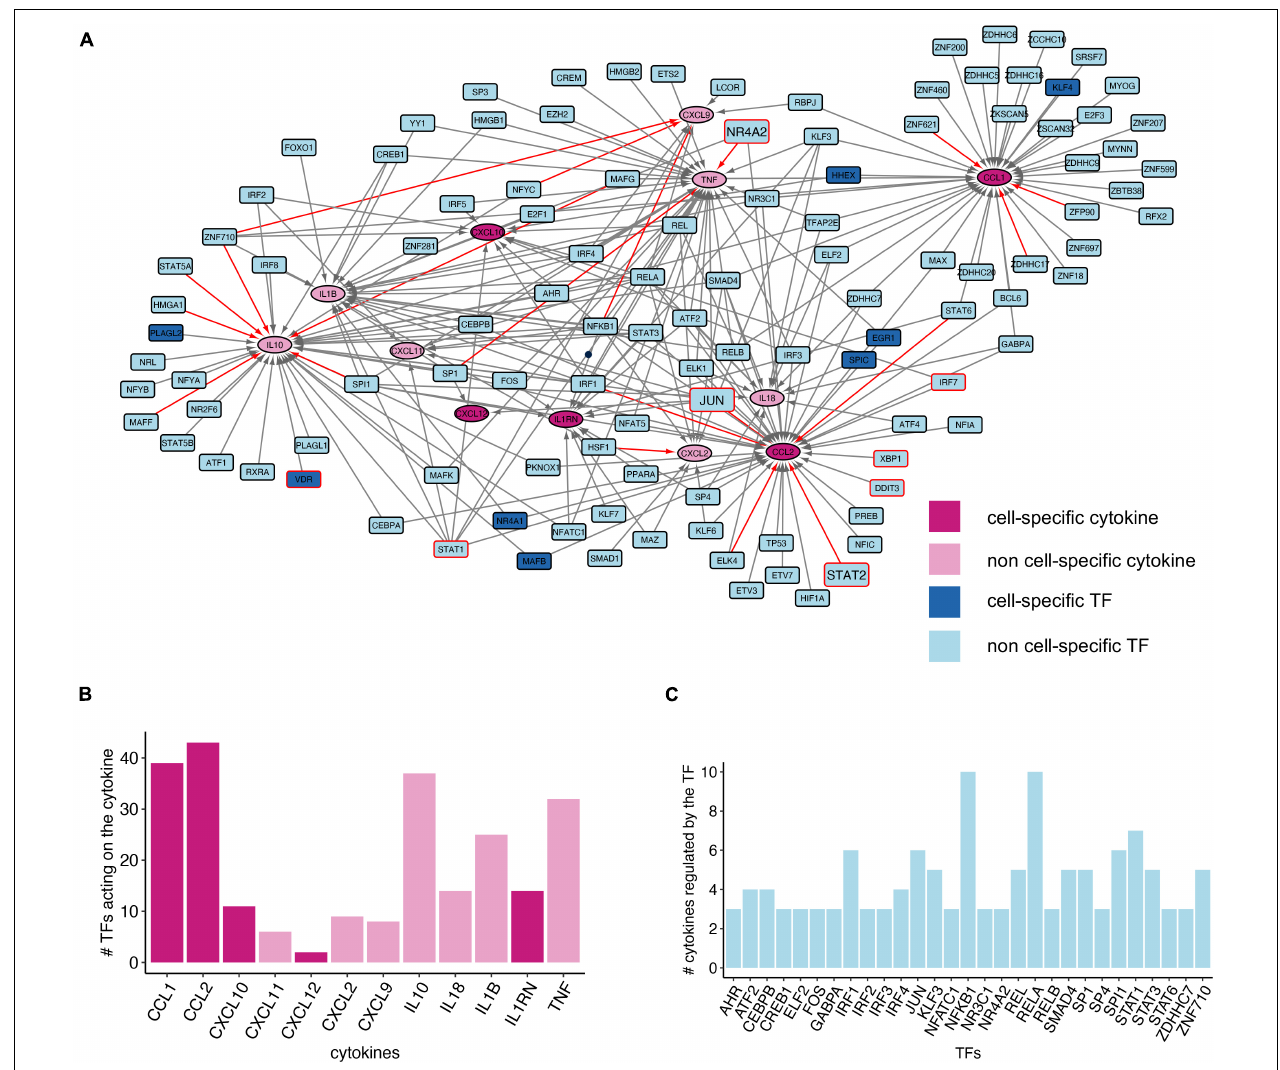
FIGURE 4 | Cytokine gene regulatory network of GD monocytes. (A) Network plot showing the TF-cytokine interactions. Only genes expressed in monocytes according to the HPA Blood Atlas data are reported. The nodes with a red border were identified in GD literature and the red edges indicate a significant correlation between TFs and cytokines. The big nodes (NR4A2, JUN, and STAT2) correspond to TFs identified in the GD literature with monocyte gene expression significantly correlated with a cytokine in the network. (B) Bar chart showing the number of incoming edges for all the cytokines in the chart, corresponding to the number of putative TFs regulating cytokine gene expression. (C) Bar chart showing the number of outgoing edges for the TF nodes with more than two degrees which corresponds to the number of cytokine genes regulated by each TF.